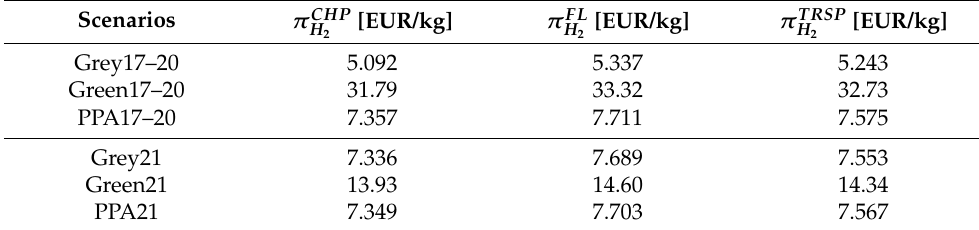
Table 6. H 2 prices for each client, to reach a 13-year payback.